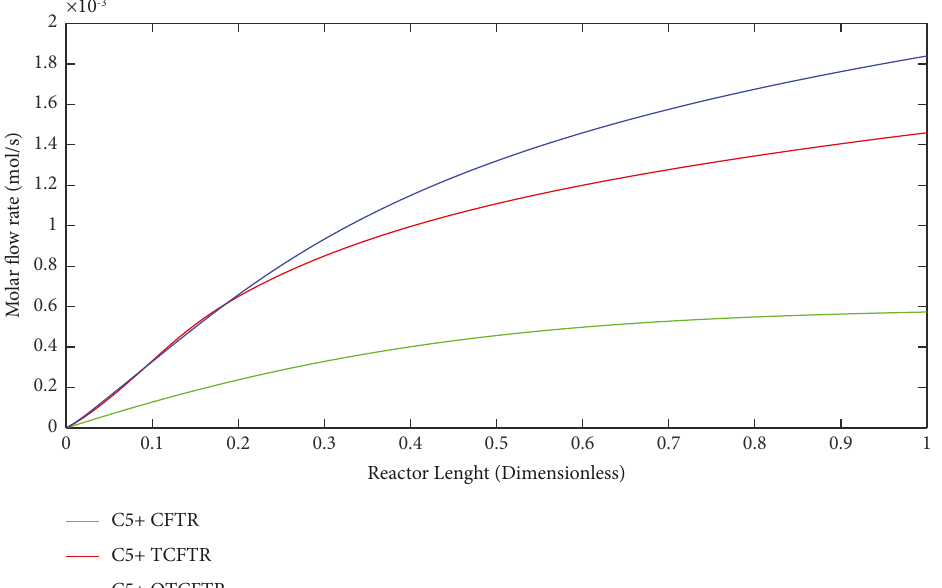
Figure 20: Comparison of the molar flow rate of gasoline in the exothermic part of the reactor for CFTR, TCFTR, and OTCFTR modes.